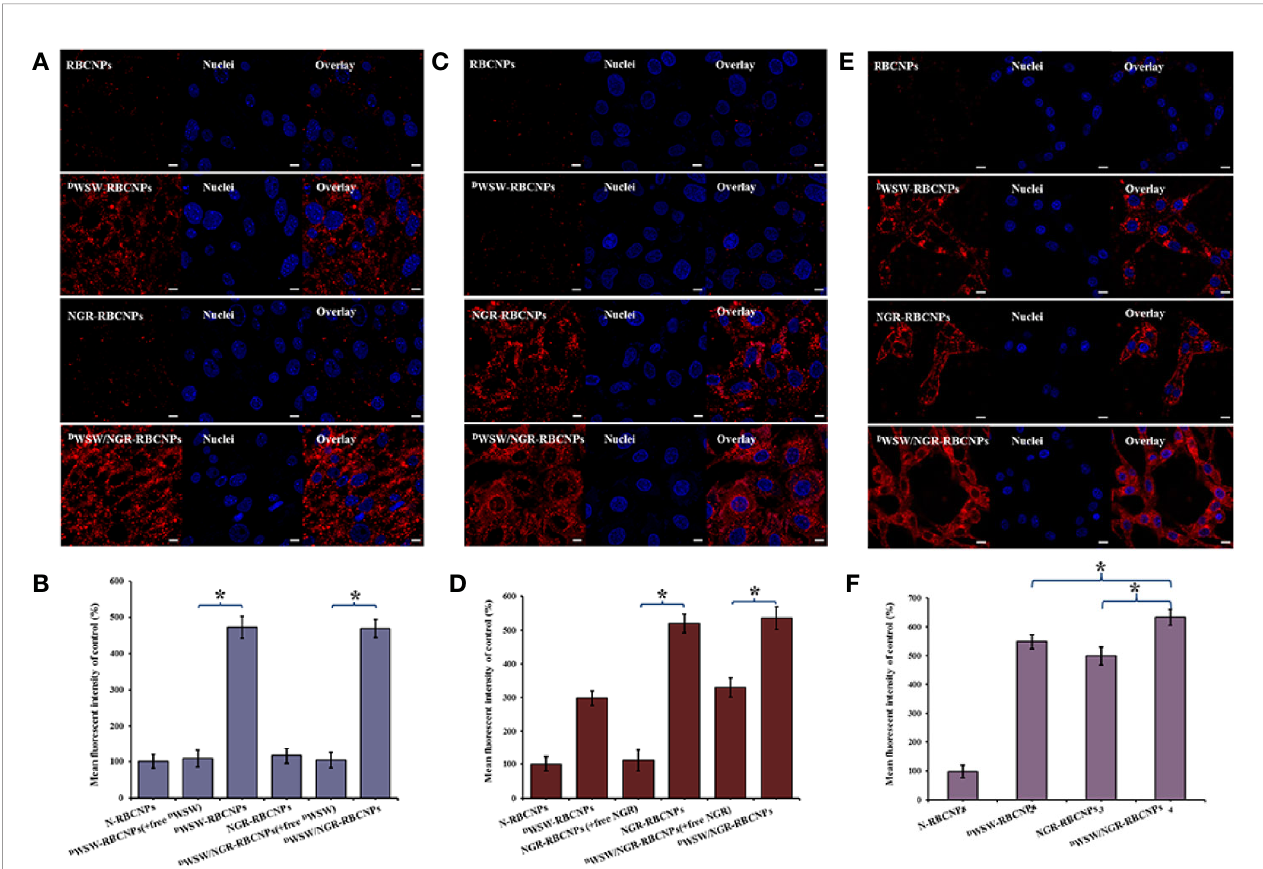
FIGURE 4 | Targeting ability test with different cells. Cellular uptake of different DiI-labelled RBCNPs by bEND.3 cells (A, B) . D WSW exhibited the ability to cross the BBB and the free peptide was able to compete for the target. NGR exhibited the ability to cross the BBTB and the free peptide was able to compete for the receptor in HUVECs cells (C, D) . D WSW- and NGR-modi fi ed nanoparticles showed good tumor-targeting in C6 cells (E, F) . DiI-positive cells were counted by FCM and intracellular fl uorescence was captured by CLSM. Nanoparticles show different targeting capabilities. Scale bars, 10 m m. * indicates P <